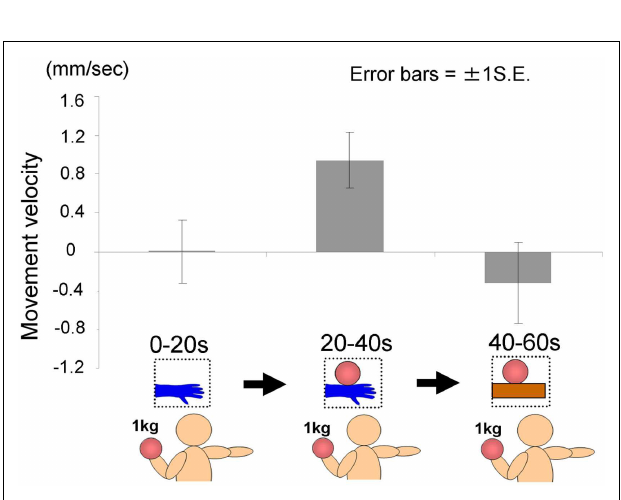
FIGURE 8 | Movement velocity in each condition in Experiment